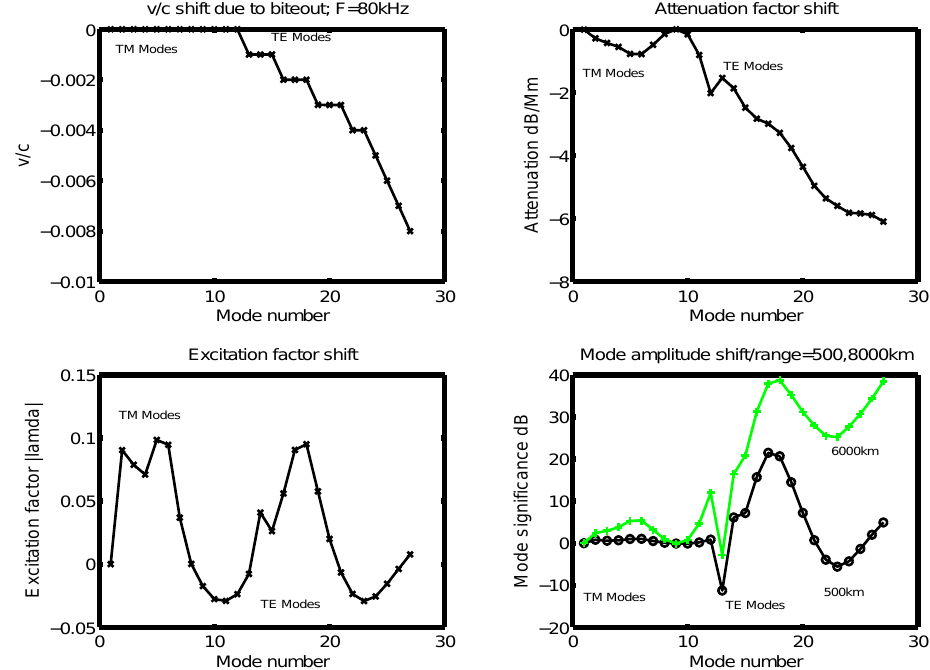
Fig. 9. Shift in modal parameters due to biteout at f =80kHz. Key features are the decreased attenuation and increased excitation of TM modes and decreased phase velocity of TE modes.